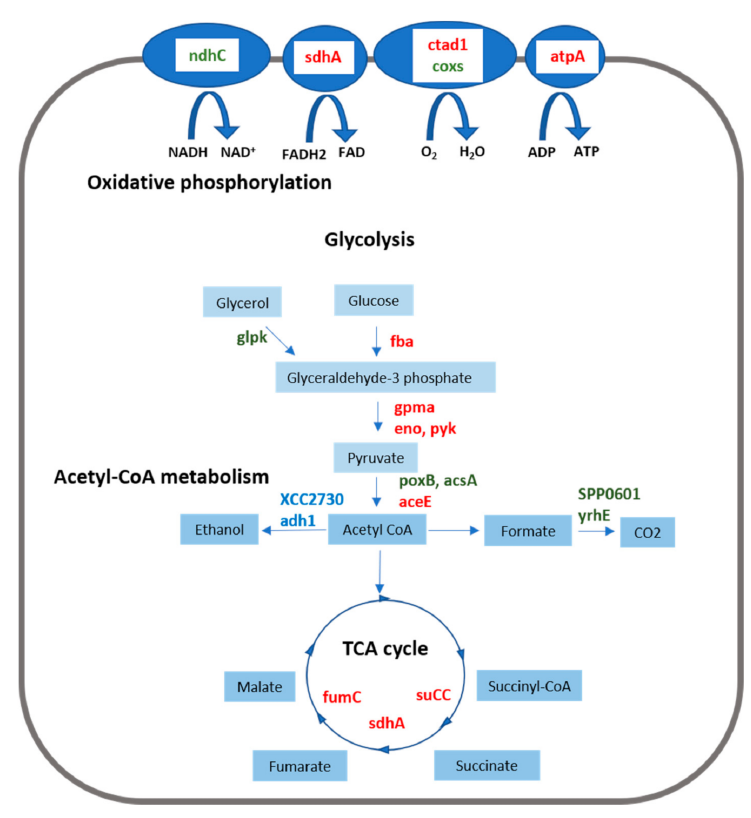
Figure 7. Schematic diagram representing DEGs integrated in the KEGG categories of glycolysis- gluconeogenesis, acetyl-CoA metabolism, citrate cycle, and energy-oxidative phosphorylation. DEGs highlighted in red are downregulated by I3C, whereas those highlighted in blue and green are upregulated by I3C and AITC, respectively. A description of DEGs is provided in Supplementary Tables S1 and